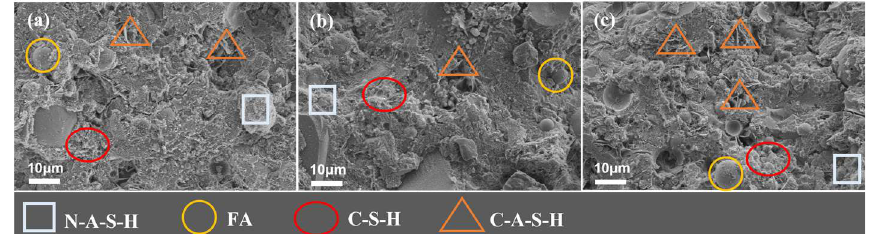
Figure 24. SEM morphology of geopolymer slurry with different Na 2 SiO 3 content (28d, slag: 40%, NaOH: 4%). ( a ) Na 2 SiO 3 content: 0%; ( b ) Na 2 SiO 3 content: 3%; ( c ) Na 2 SiO 3 content: 6%.